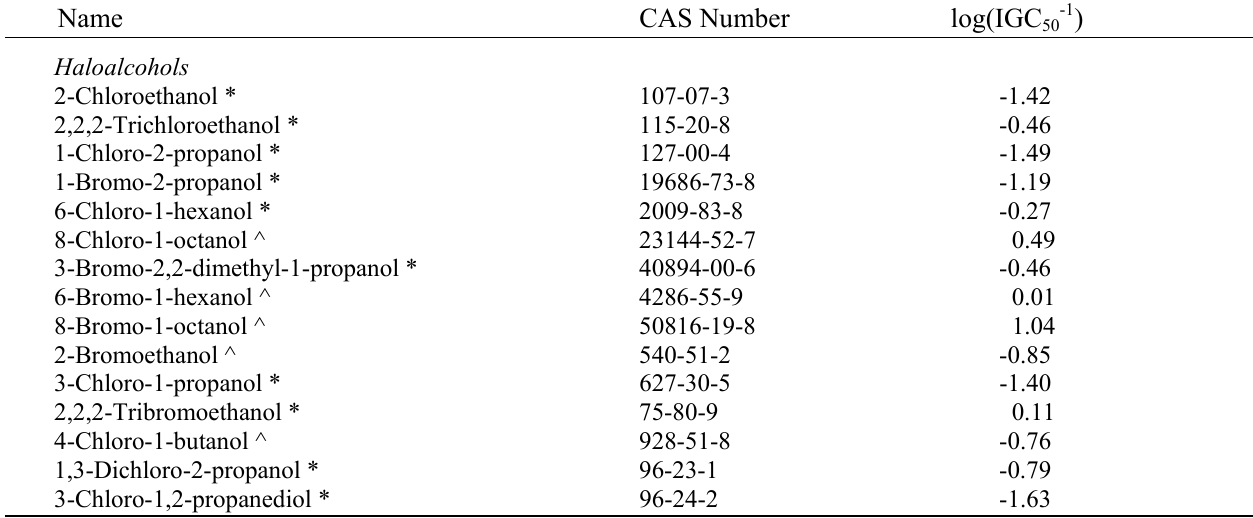
Table 1 . Toxicity data for compounds considered in this